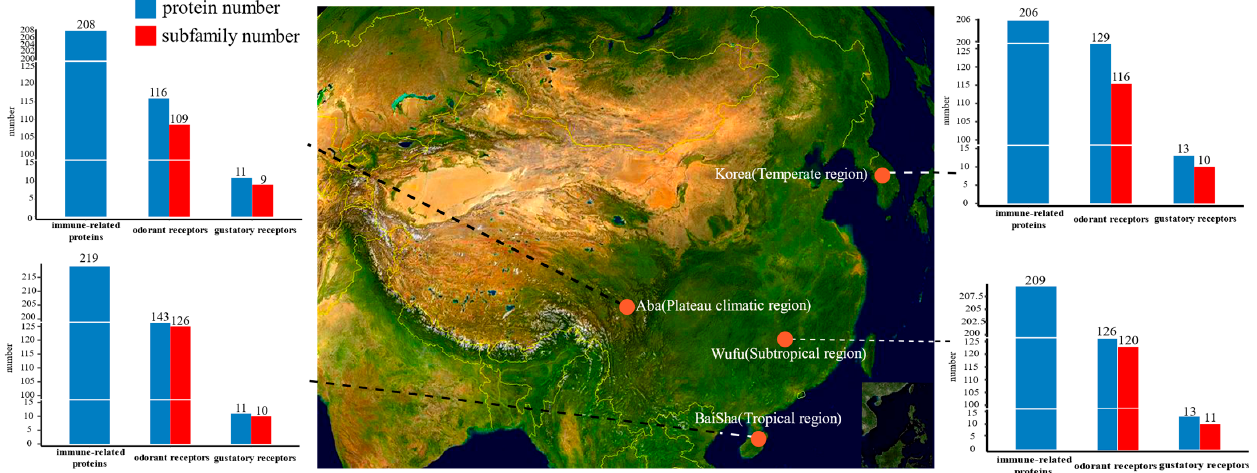
Figure 2. Sample collection sites for each A. cerana genome and the type of climate in which they are located. The bar histogram indicates the number of chemoreceptors and subfamilies identified in the different strains and the number of their immune-related proteins.